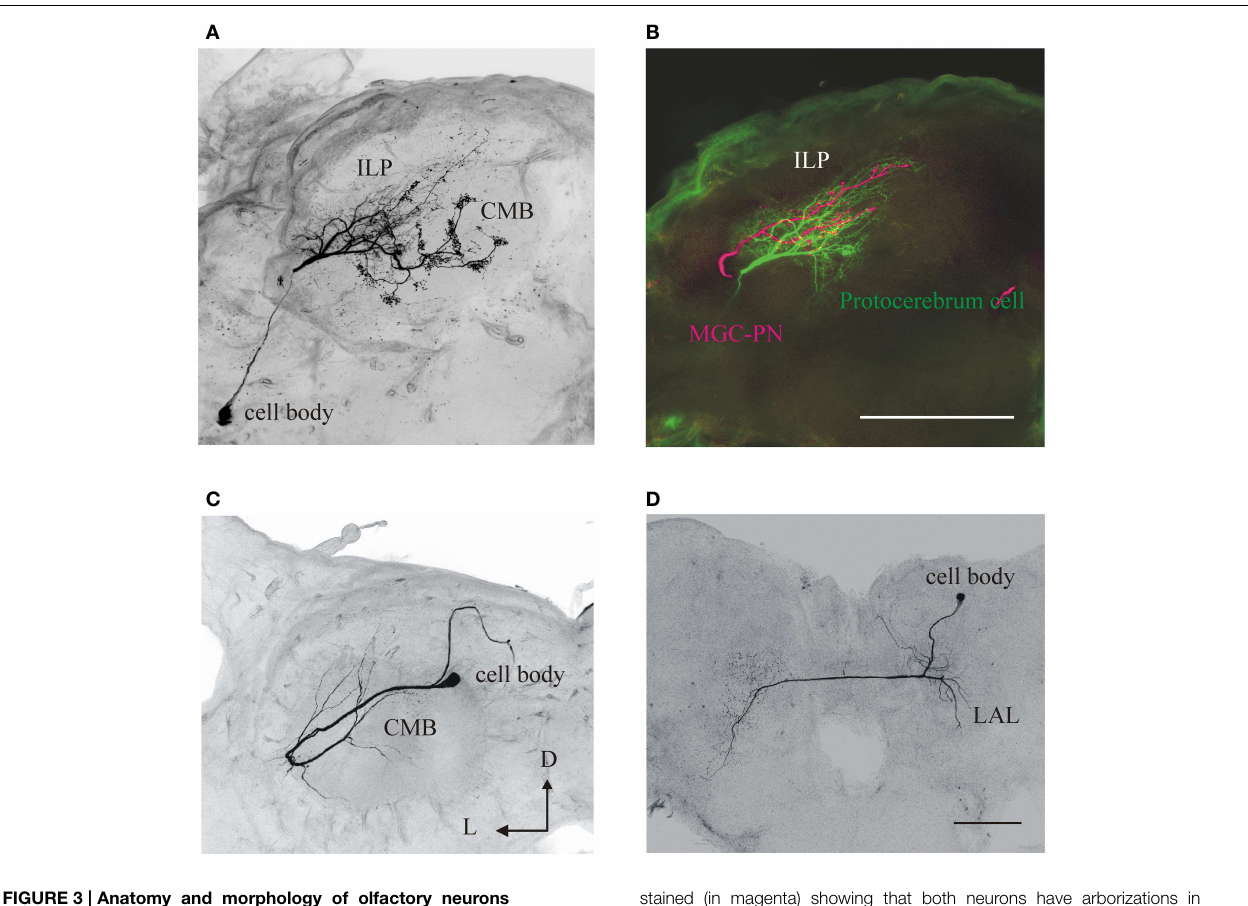
FIGURE 3 | Anatomy and morphology of olfactory neurons arborizing in second and third-order brain centers in M. sexta . These neurons might respond to other sensory modalities. (A) A protocerebral neuron with dendritic arborizations in the inferior lateral protocerbrum (ILP) and the calyx of the mushroom bodies (CMB). (B) In the same preparation a male-specific (MGC) neuron was differentially